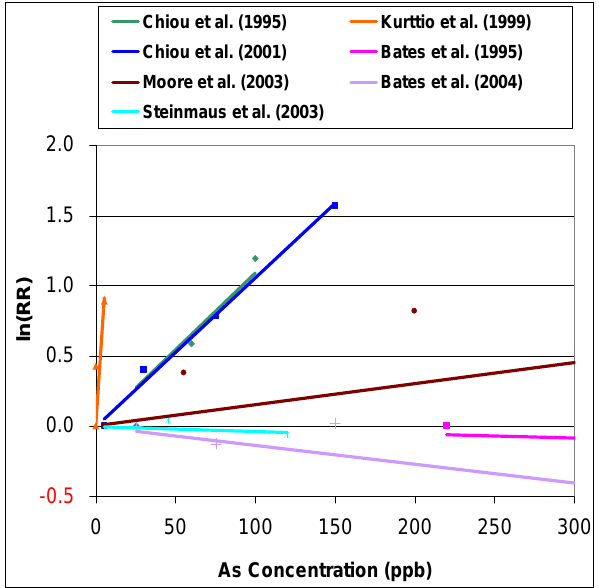
Figure 1: Dose-response analysis of relative risk of bladder cancer for arsenic intake from drinking water.